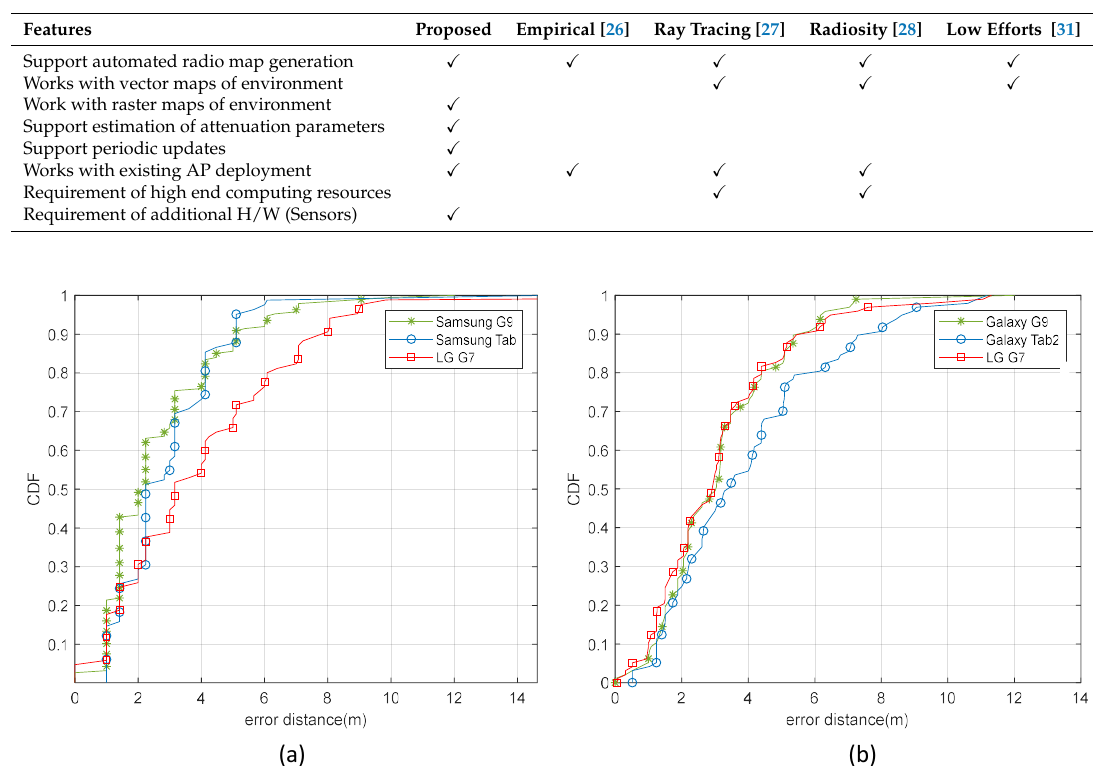
Table 5. Qualitative comparison of the proposed system with other radio map generation techniques.